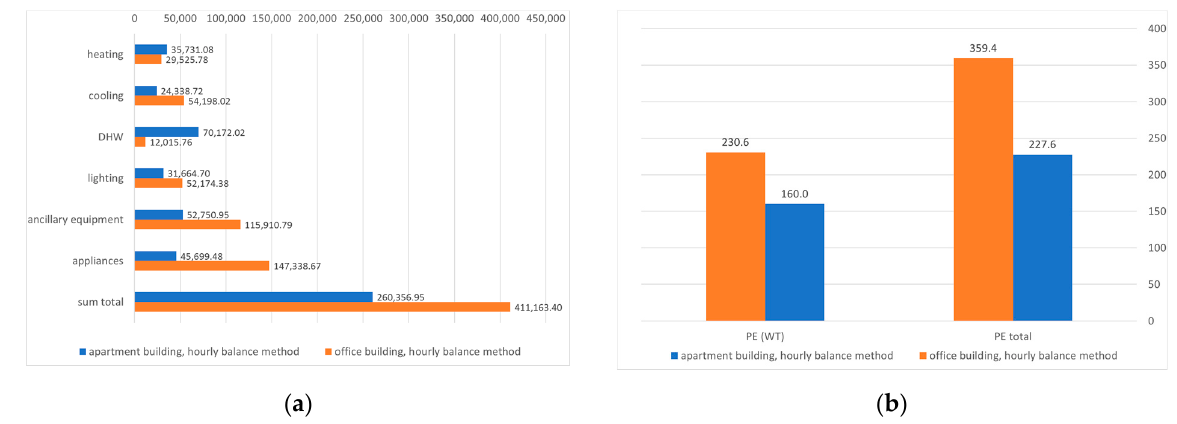
Figure 13. Partial primary energy. ( a ) Partial primary energy for both building uses with cooling, ( b ) Primary energy indicator for both building uses with cooling.